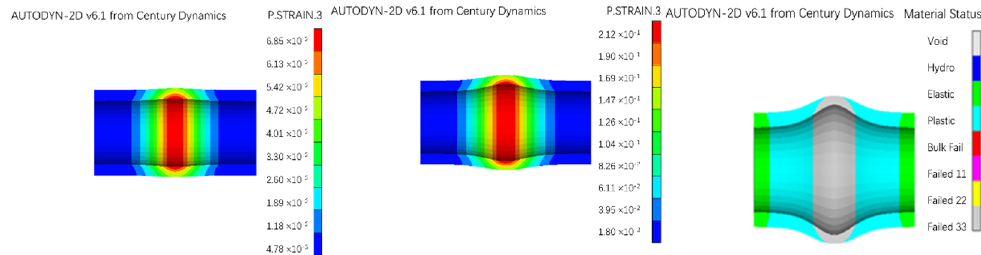
Figure 7. Circumferential strain cloud of 14 mm-thick shell at 80, 145, and 233 g TNT.